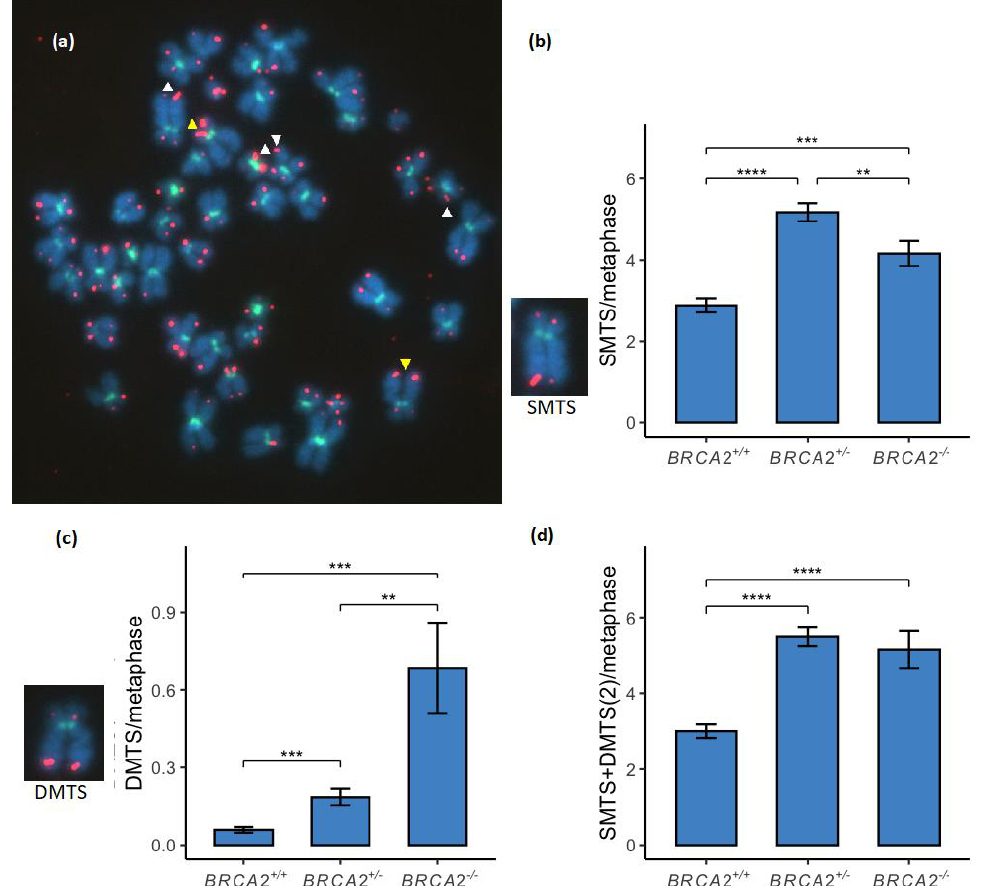
Figure 2. Multitelomeric signals (MTS) on chromosome ends compared between the three BRCA2 genotypes of lymphoid cell lines. ( a ) Single-MTS (SMTS) on chromosome ends were measured as an MTS on a single sister chromatid (white triangles) and double-MTS (DMTS) on chromosome ends when both sister chromatids had MTS on a chromosome end (yellow triangles). ( b ) SMTS was significantly increased between the BRCA2 wild-type and the BRCA2 +/ − lymphoid cell lines ( p < 0.0001) and the BRCA2 − / − lymphoid cell lines ( p < 0.001). A significant difference was found between the BRCA2 +/ − and BRCA2 − / − genotypes ( p < 0.01). ( c ) DMTS were significantly increased between the three genotypes of BRCA2 +/+ , BRCA2 +/ − and BRCA2 − / − in a stepwise manner ( p < 0.001 and p < 0.01, respectively) and a significant difference was also found between the BRCA2 +/+ and BRCA2 − / − geno- types ( p < 0.001). ( d ) Total MTS were measured by a combination of numbers of SMTS and DMTS duplicated. MTS was significantly increased between the BRCA2 wild-type, BRCA2 +/ − and BRCA2 − / − genotypes ( p < 0.0001). No difference was, however, found between the BRCA2 +/ − and BRCA2 − / − gen- otypes in total MTS. ** corresponds to p < 0.01, *** corresponds to p < 0.001 and **** corresponds to p < 0.0001. Metaphase chromosomes were analyzed with FISH by Cy3-conjugated telomere probe and FITC-conjugated centromere probe and counterstained with DAPI. The metaphase shown is from the EB2302 BRCA2 +/ − lymphoid cell line.